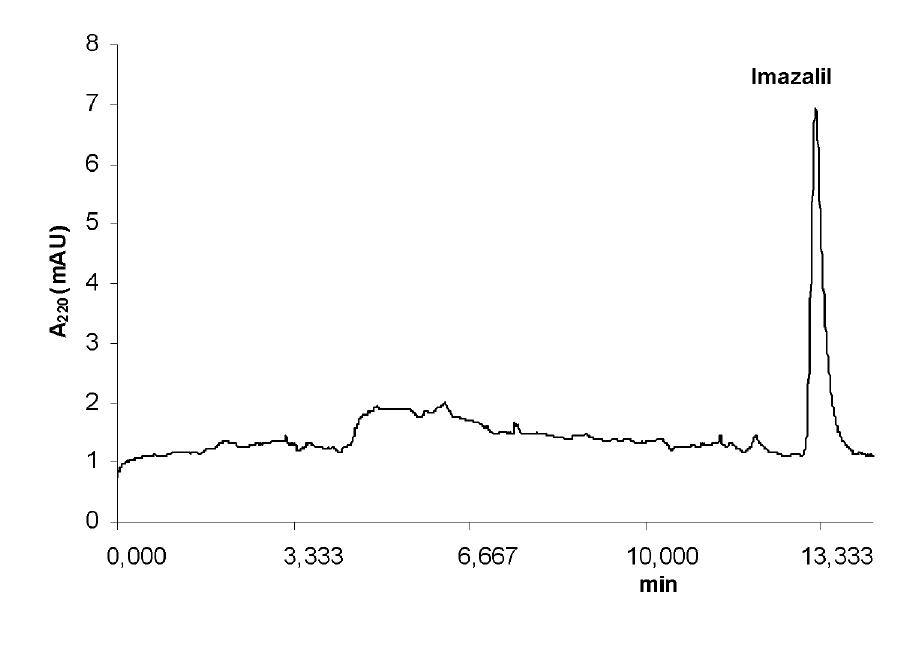
Fig. 2 Electropherogram of standard solution of imazalil (50 ng mL ¡ 1 )